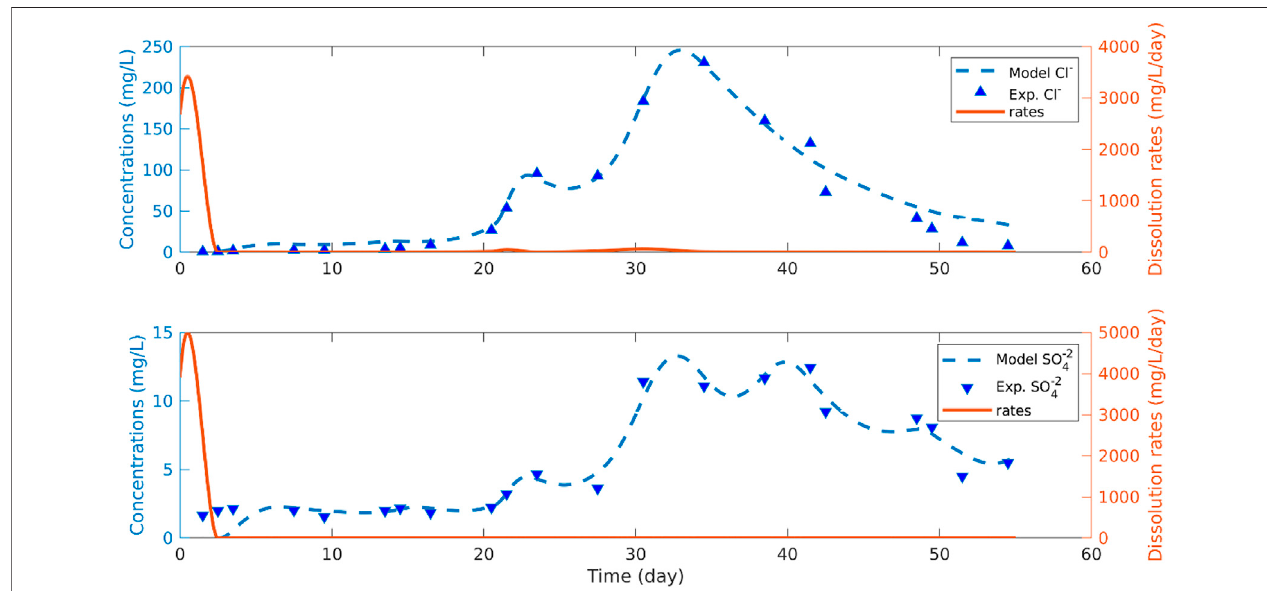
FIGURE 6 | Model fi t of Cl − and SO 42- to the measured leachate concentrations in the fertilized soil columns. The experimental Cl − and SO 42- data are averaged from the fertilized columns.